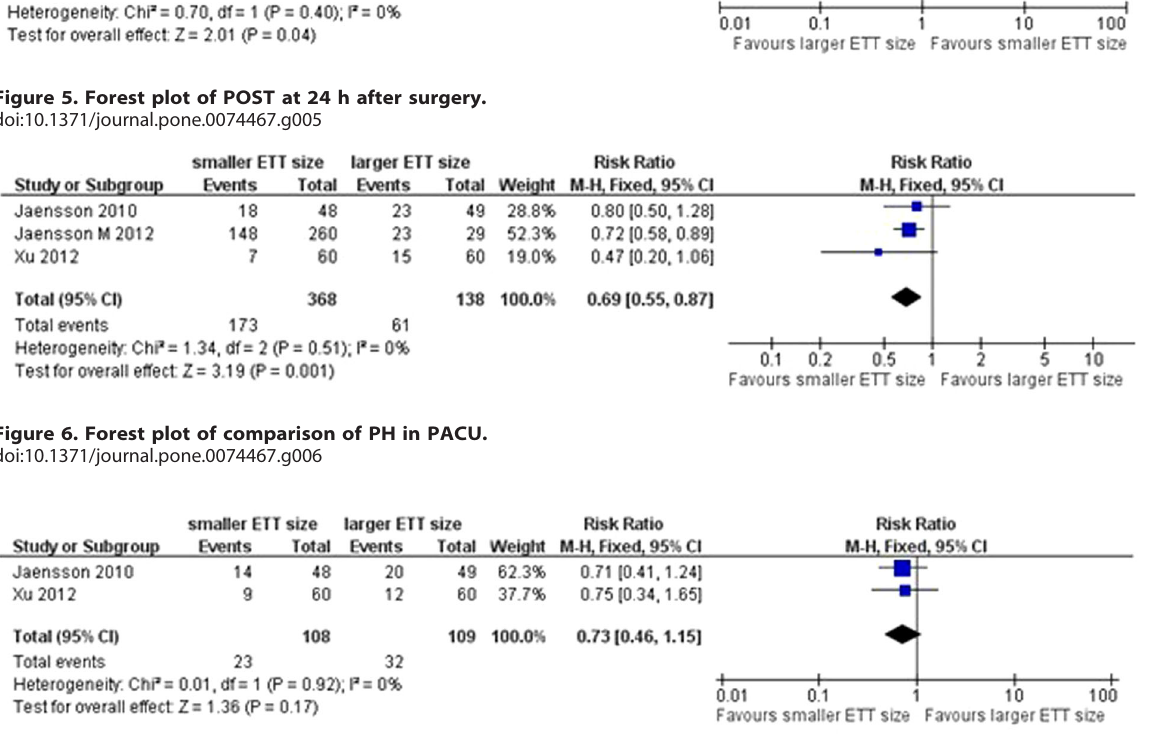
Figure 7. Forest plot of comparison of PH at 24 h.